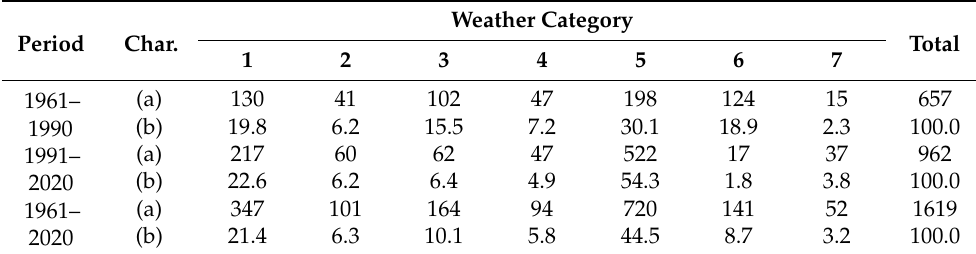
Table 1. (a) Numbers of weather-related fatalities (1—flood, 2—windstorm, 3—convective storm, 4—snow and glaze ice, 5—frost, 6—fog, 7—other severe weather), and (b) their proportions to